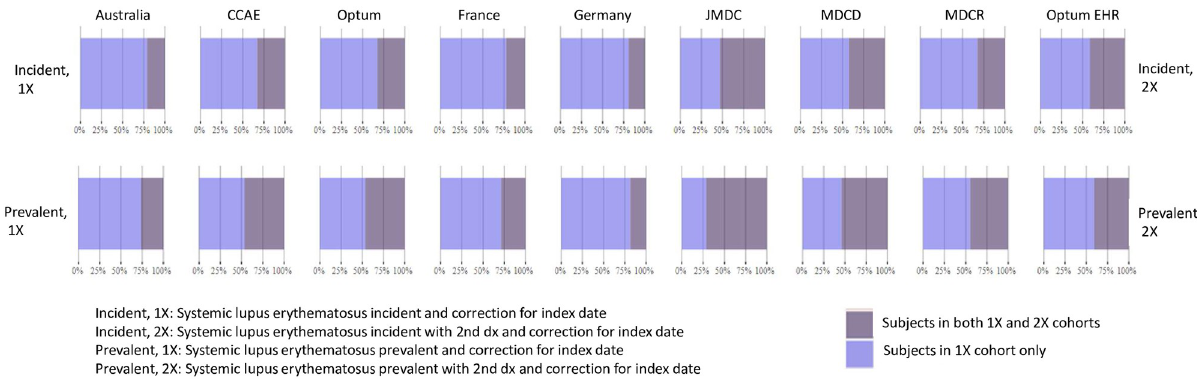
Fig 2. Graphical depiction of the overlap in subjects between the two incidence cohorts and the two prevalence